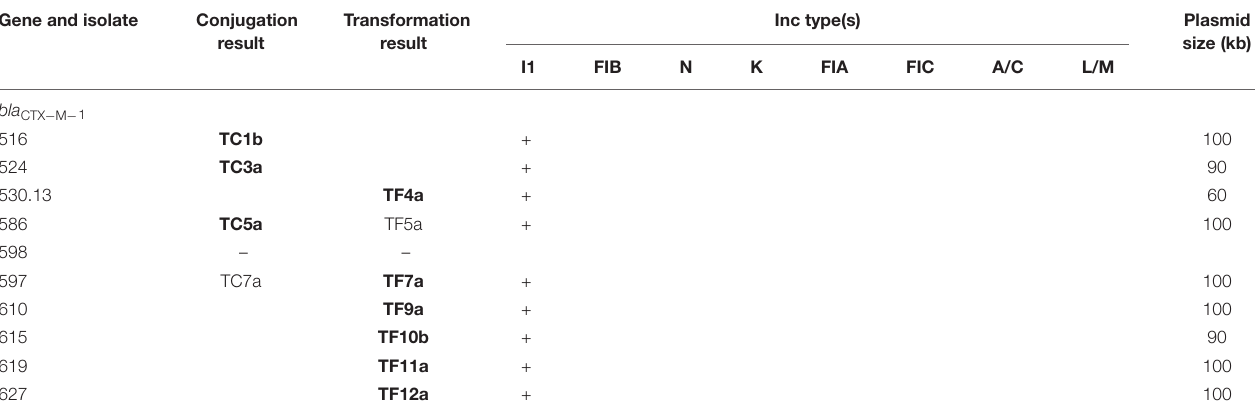
TABLE 2 | Characteristics of plasmids harboring ESBL and/or pAmpC genes from 42 cephalosporin-resistant E. coli isolates. Gene and